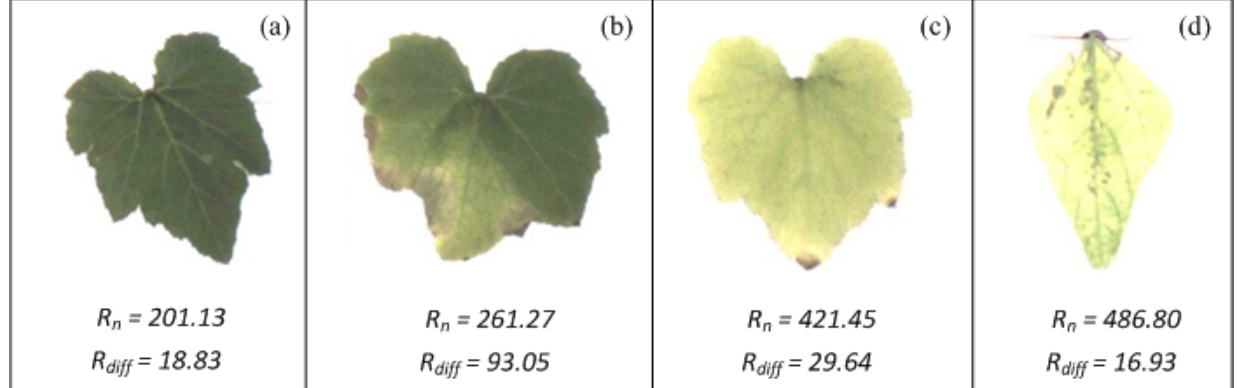
Figure 13. Different levels of generalized and localized chlorosis in pumpkin and pepper leaves. ( a ) Pumpkin leaf with the low-generalized and localized chlorosis. ( b ) Pumpkin leaf with high-localized chlorosis. ( c ) Pumpkin leaf with high-generalized chlorosis. ( d ) Pepper leaf with high-generalized chlorosis.